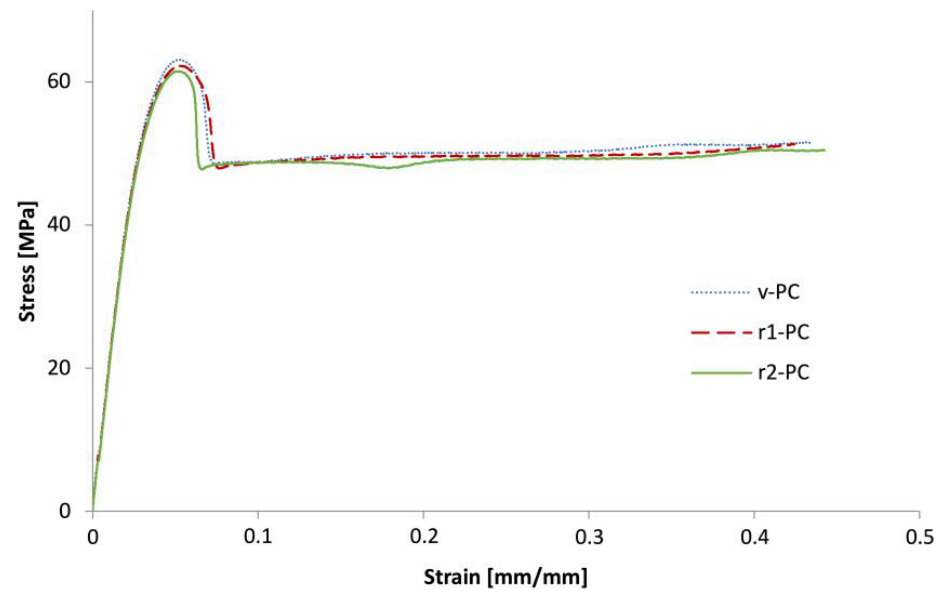
Figure 3. Stress–strain curve of virgin and recycled PC.